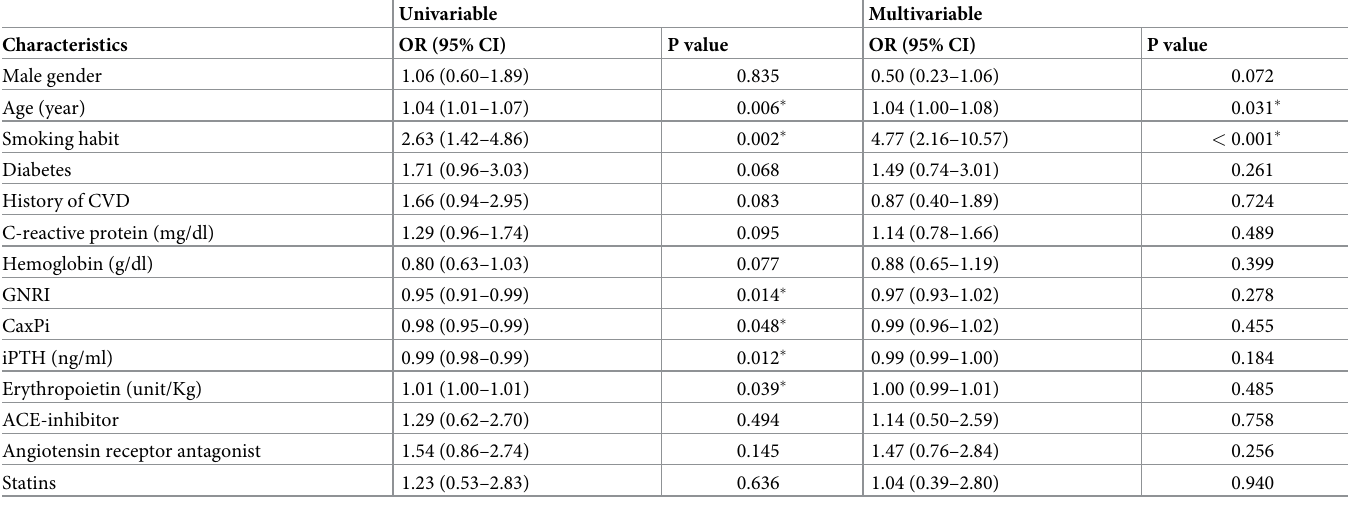
Table 2. Associated factors with the lowest level of CD34 + cells using logistic regression